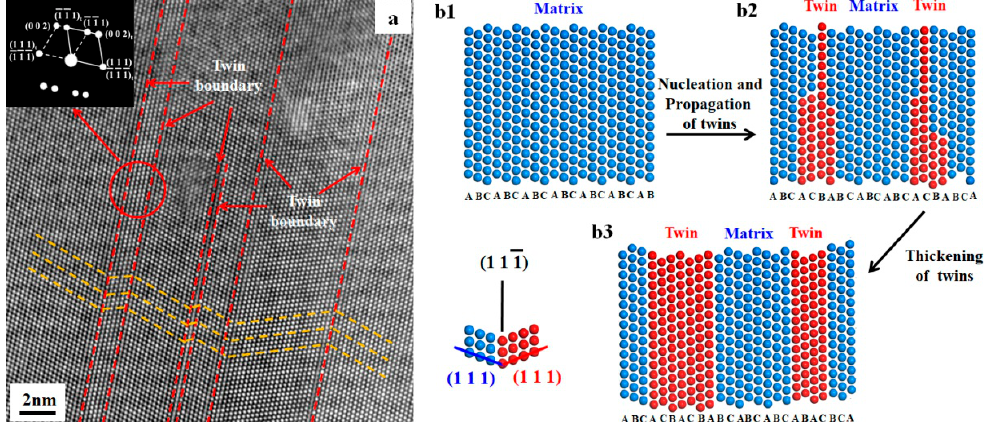
Figure 5. ( a ) High resolution TEM micrographs and a fast Fourier transform pattern of twins observed in γ‐ TiAl lamellae of TNM alloy deformed at 25 °C; a schematic model showing twinning evolution of the γ‐ TiAl phase in the TNM alloy; ( b1 ) original state of the material; ( b2 ) nucleation and propagation of twins; ( b3 ) the thickening and boundary migration of twins.